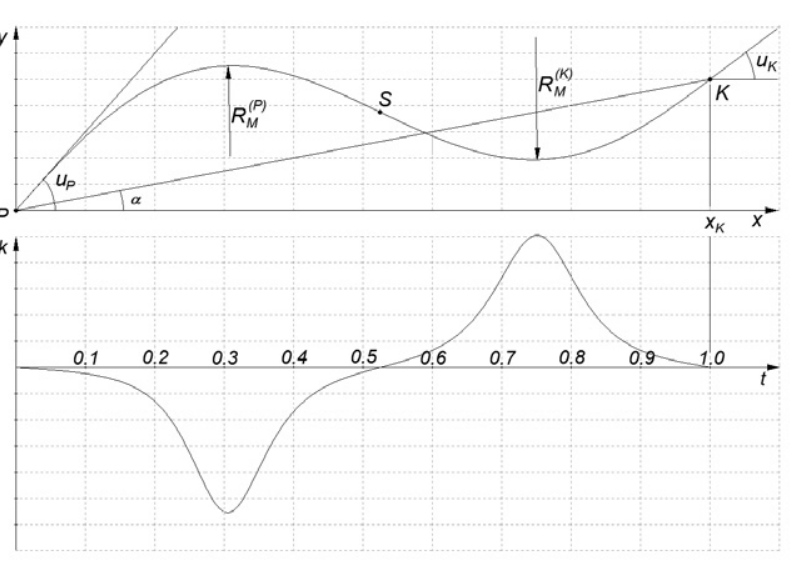
Figure 1. S -shaped transition curves and graph of her